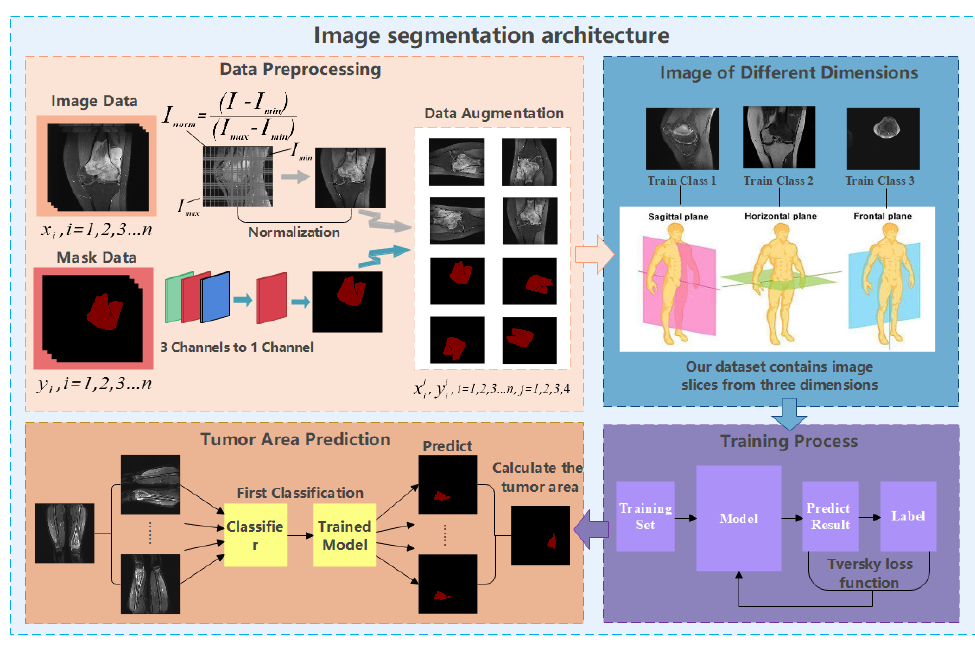
Figure 1. Architecture diagram of OMSAS. Table 1. Description of relevant symbols in the chapter.